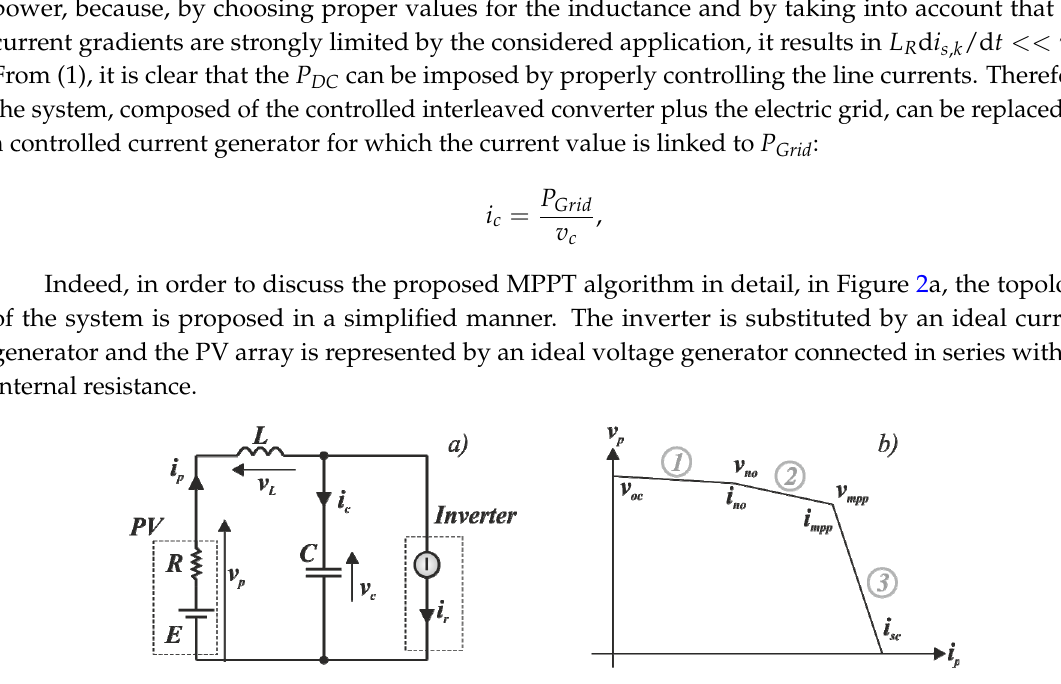
Figure 2. Simplified grid connected PV system: ( a ) linear circuit; ( b ) linearized PV characteristic.